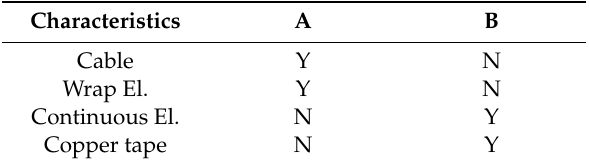
Table 3. Di ff erent features of the assembly for Configuration A and